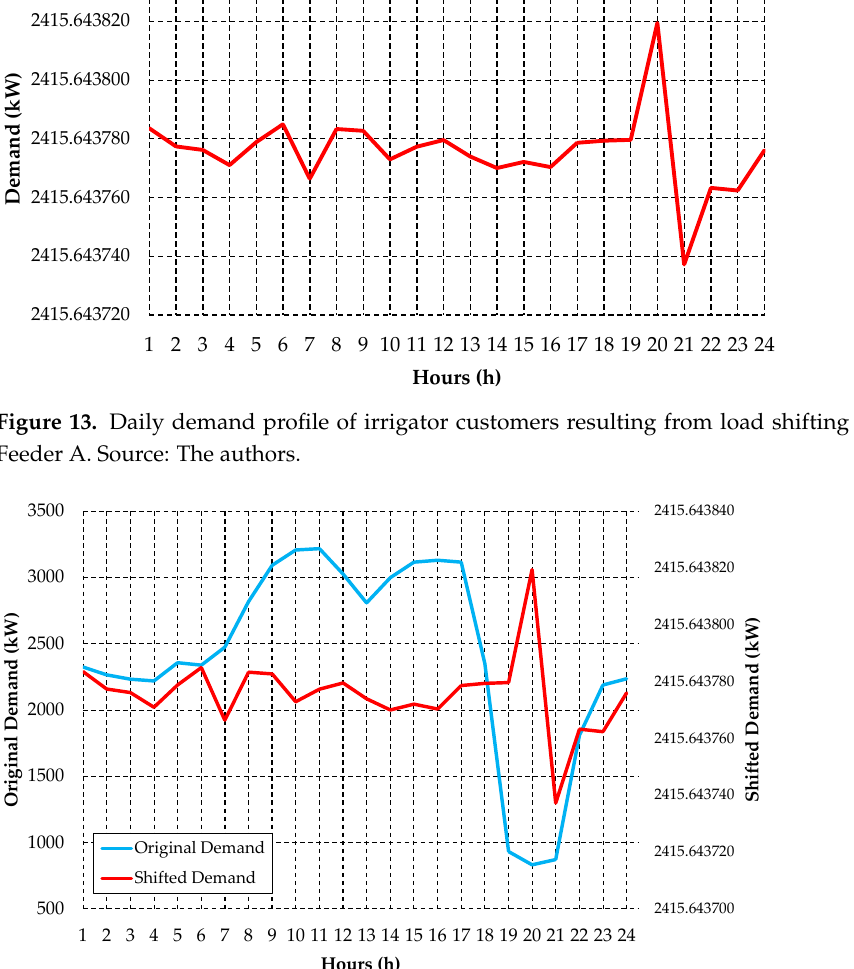
Figure 14. Comparison of the original and shifted demand profiles for Rural Feeder A. Source: The authors.